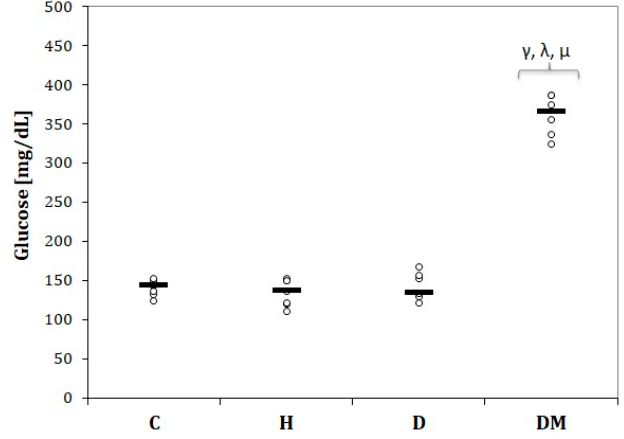
Figure 3. Serum glucose variation by groups; C = Control group, H = Hypertension group, D = Dyslipidemia group, DM = Type 1 Diabetes Mellitus group. The letter codes correspond to the Kruskal–Wallis post-hoc p -values: < 0.02, γ DM compared to C, < 0.004, λ DM compared to H, < 0.04, µ DM compared to D.